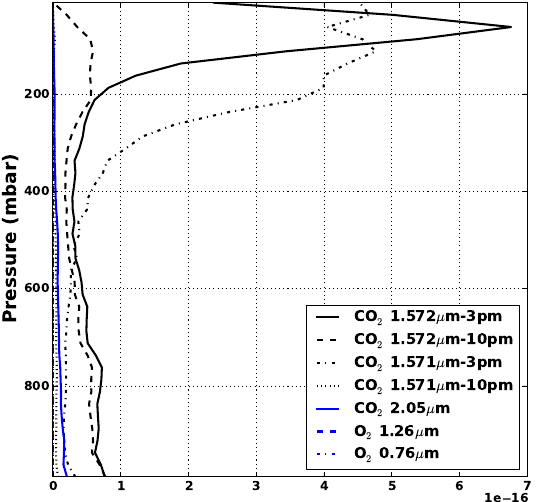
Figure 4. The variance of the differences between differential op- tical depth WFs derived from observed and modeled atmospheric soundings as a function of pressure (in 25mb layers). The enhanced variability in the 1.571µm–3pm and 1.572µm–3pm WFs is likely due to the strong gradients in T and Q across the tropopause, which can be located at different heights in NWP models versus rawinson- des, as is evident from Fig.